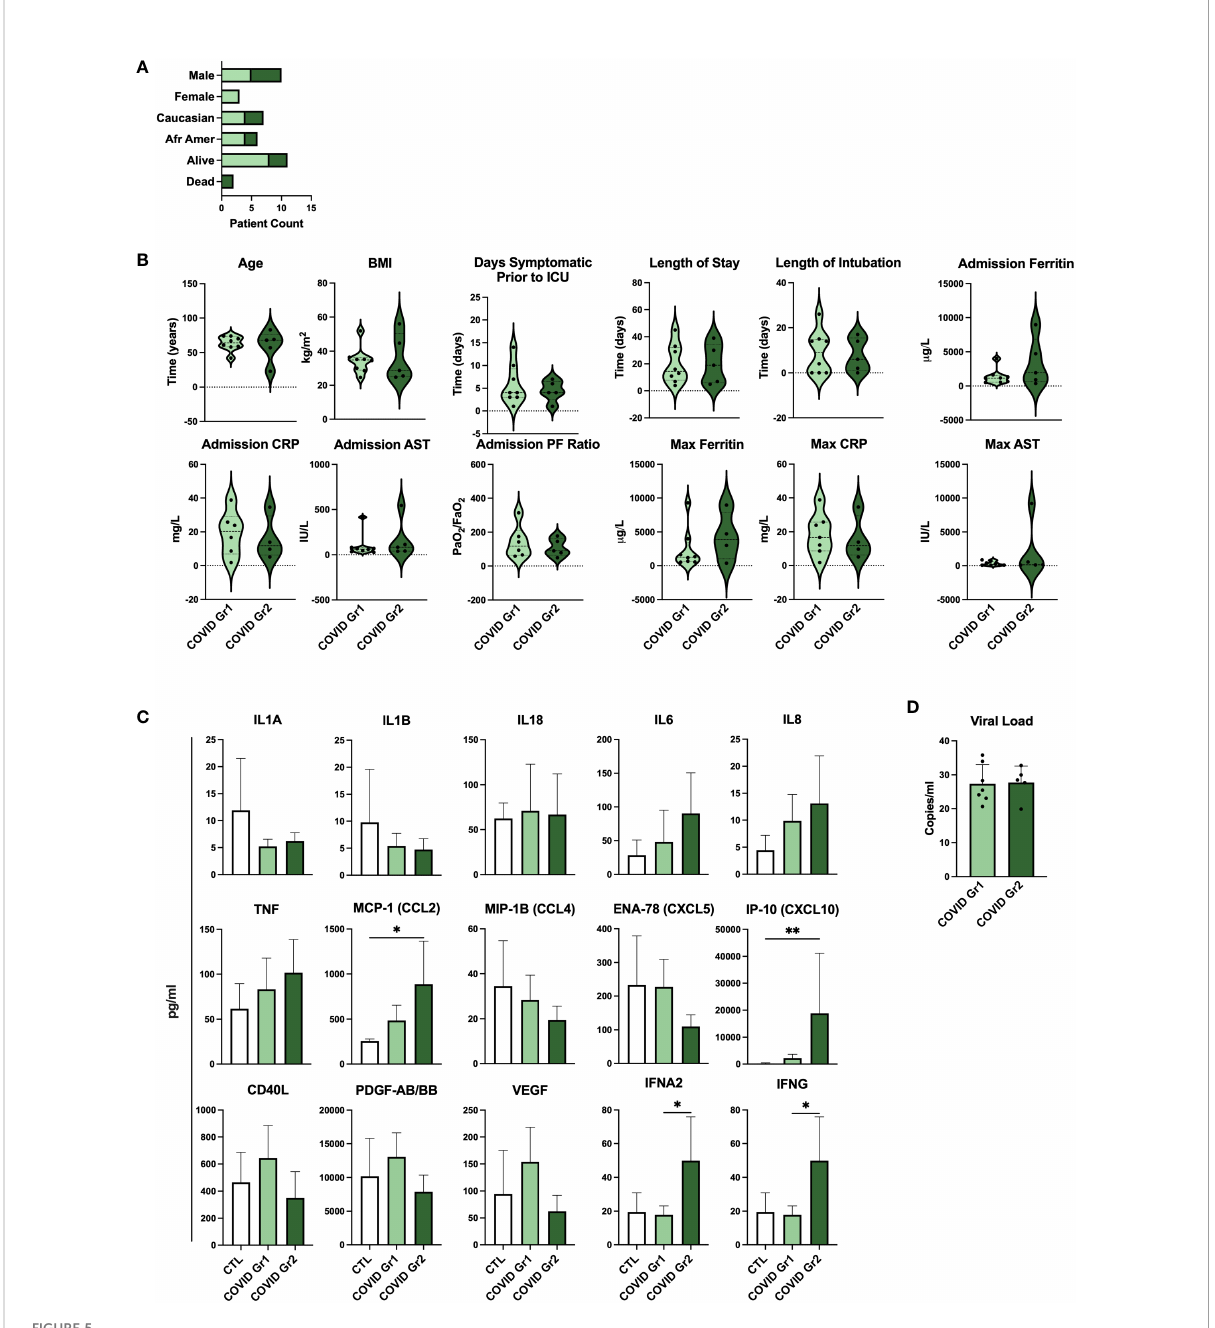
FIGURE 5 Serum cytokines, but not viral load, are indicative of differential disease severity in gene expression-derived COVID-19 patient groups. (A) Demographic data and (B) clinical feature data from COVID Group and COVID Group 2 patient cohorts. (C) Serum cytokine measurements from Control, COVID Group 1, and COVID Group 2 ICU patient cohorts. (D) SARS-CoV-2 viral load CT values of nasal swabs from COVID-19 ICU patient cohorts. *p < 0.05, **p <